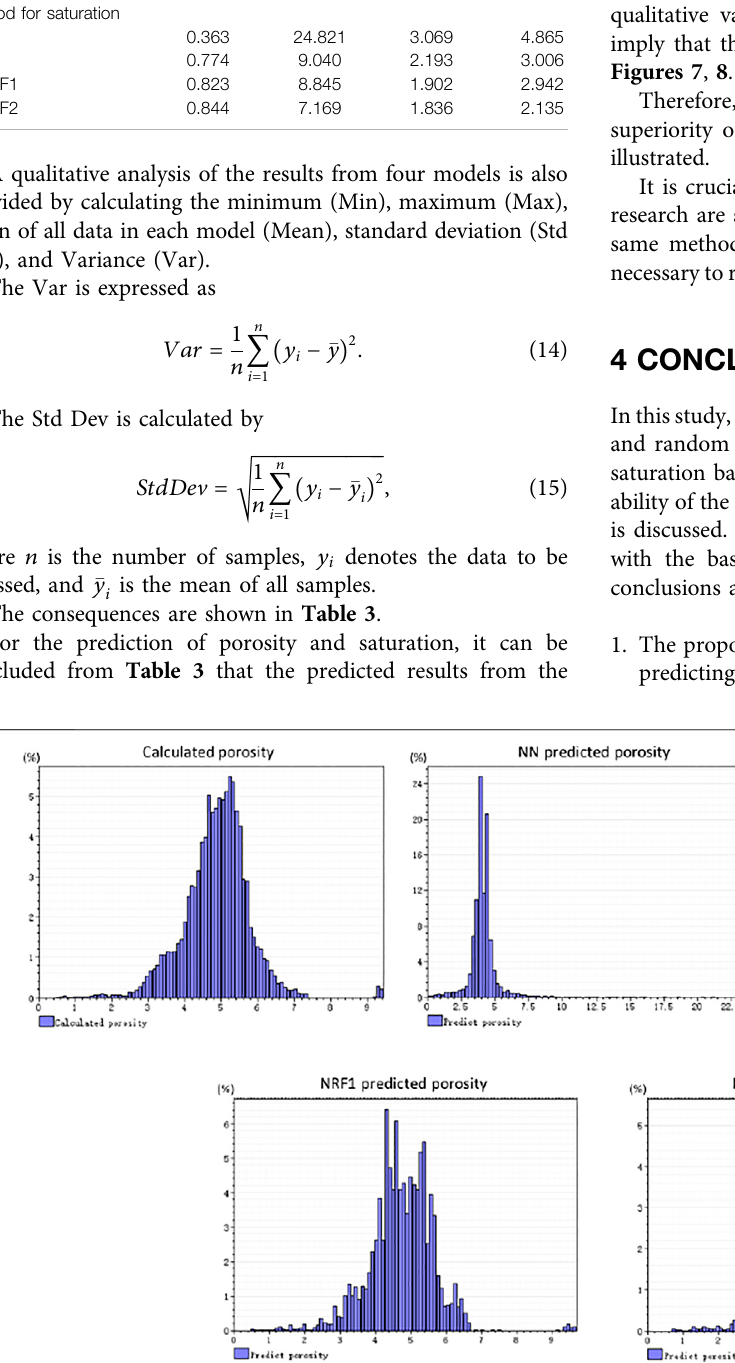
FIGURE 9 | Histogram of porosity data